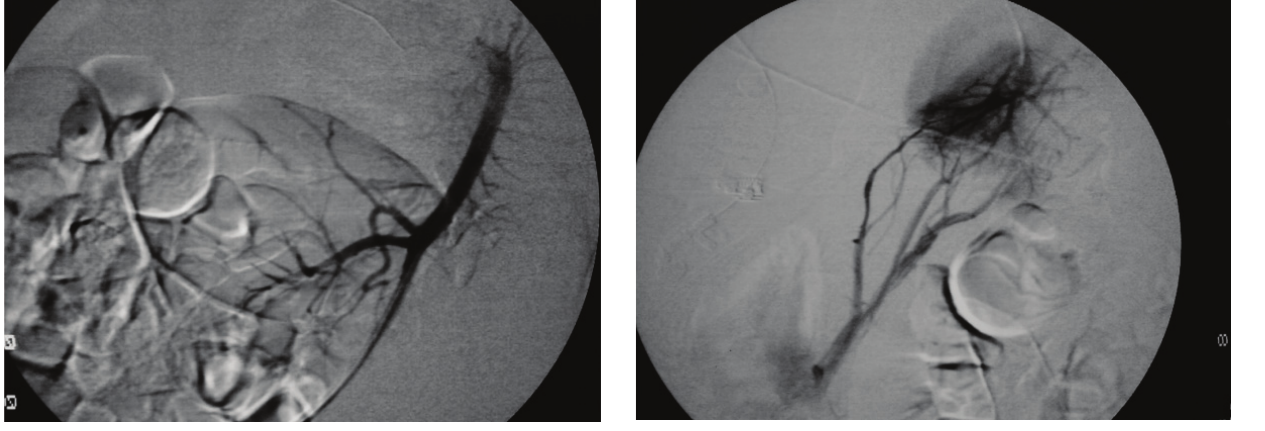
Figure 3 - Selective catheterization through the jugular access of the smaller twin, displaying communication of her hepatic vein with the inferior vena cava of the bigger twin